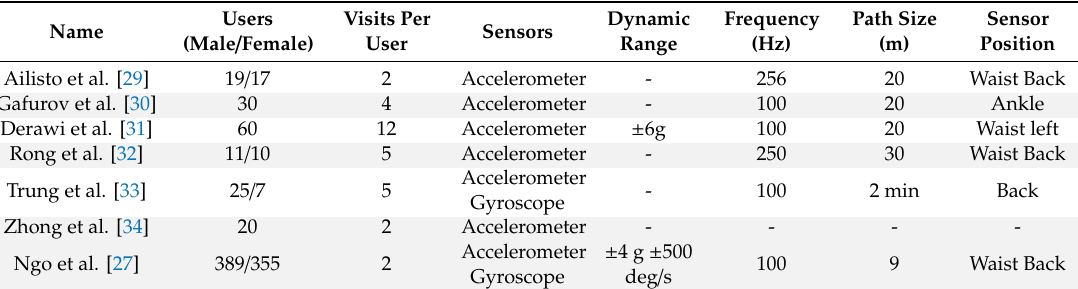
Table 1. Databases used in the previous